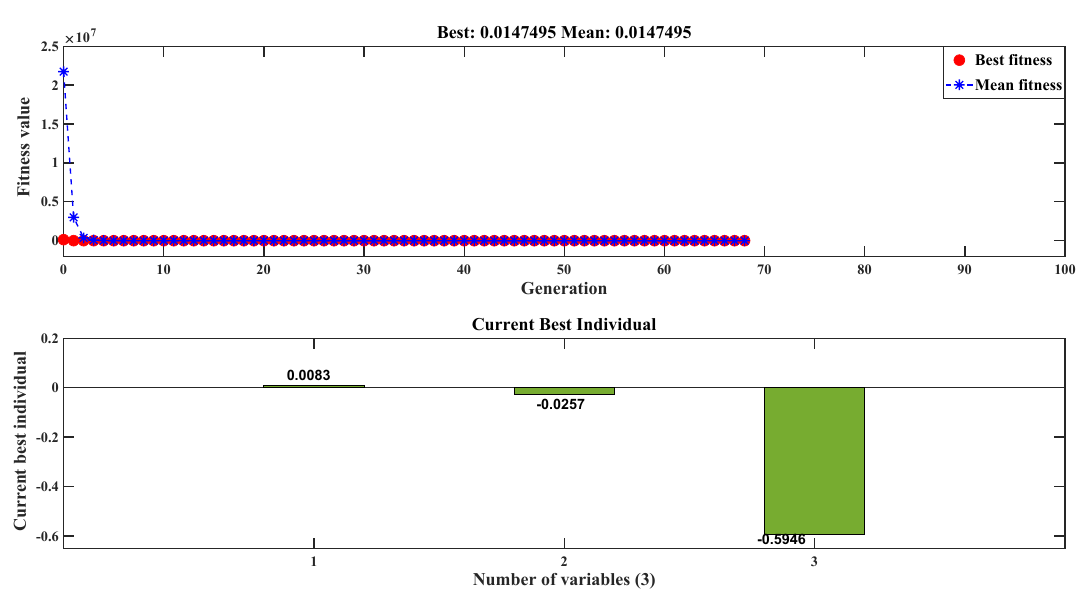
Figure 9. Genetic Algorithm generation and individuals value for unloading